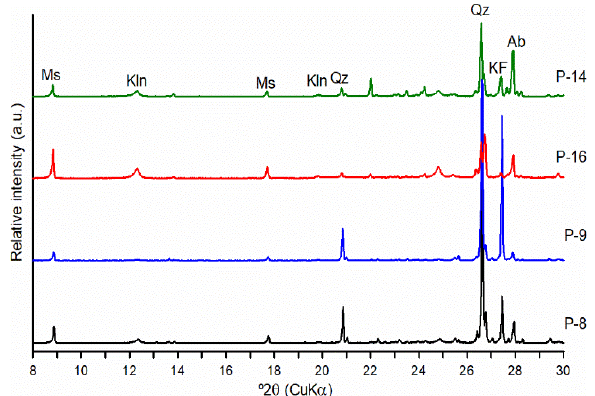
Figure 6. X-ray powder diffraction (XRD) diagrams showing the mineralogical composition of samples from the leucogranite (Pen-14) and from the Balsa Grande (Pen-8, Pen-9) and Balsa Pequeña tailings (Pen-16). Qz, quartz; Ab, albite, KF, K-feldspar; Ms, muscovite; and Kln, kaolinite.